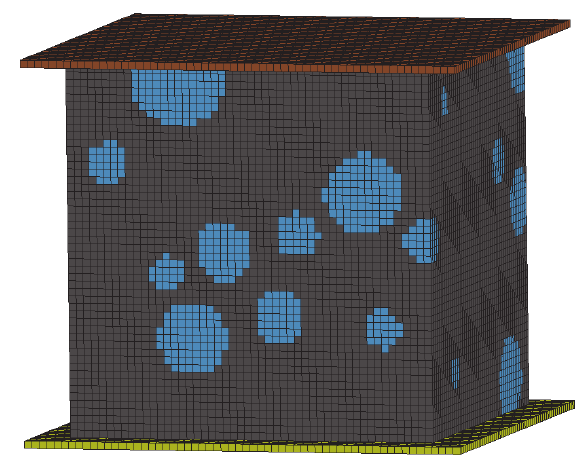
Figure 1: 3D meso-mechanical